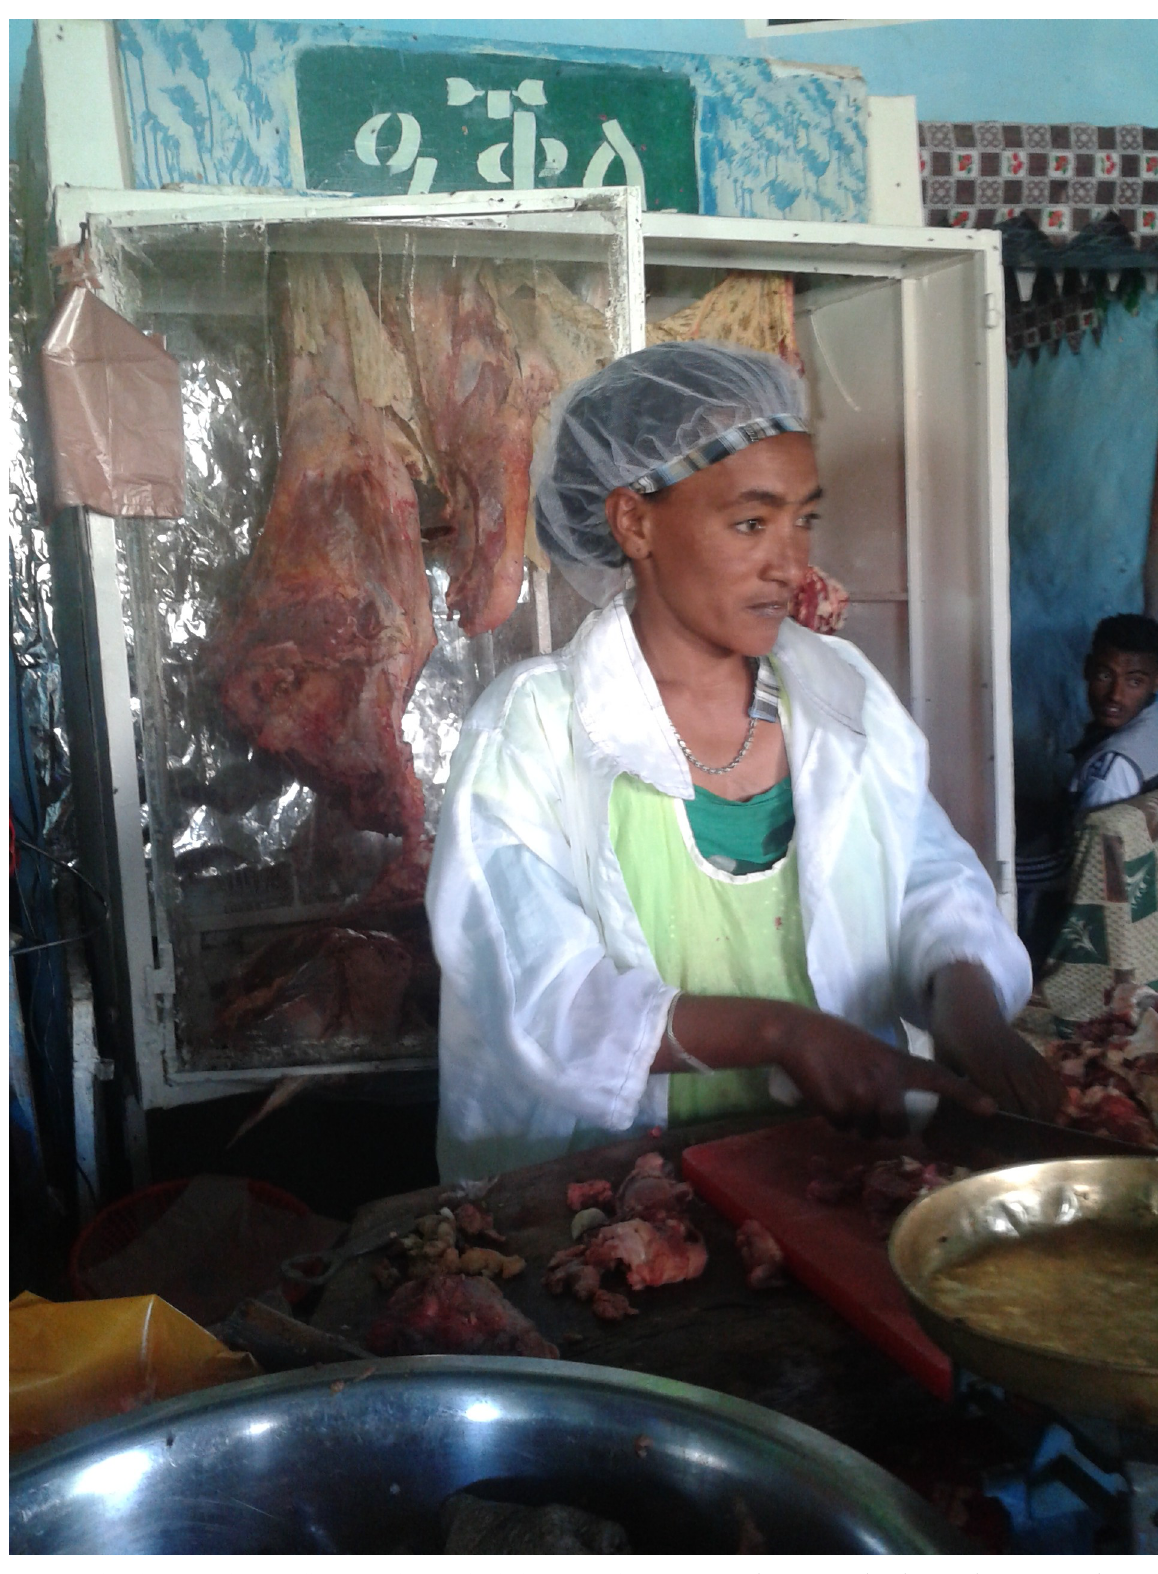
Fig 1. Butcher shop in study area selling animal source foods during non-fasting time � . � . The person in this photograph was not a study participant and has given permission for the image to be used widely and published. https://doi.org/10.1371/journal.pone.0208408.g001 PLOS ONE | https://doi.org/10.1371/journal.pone.0208408 December5,